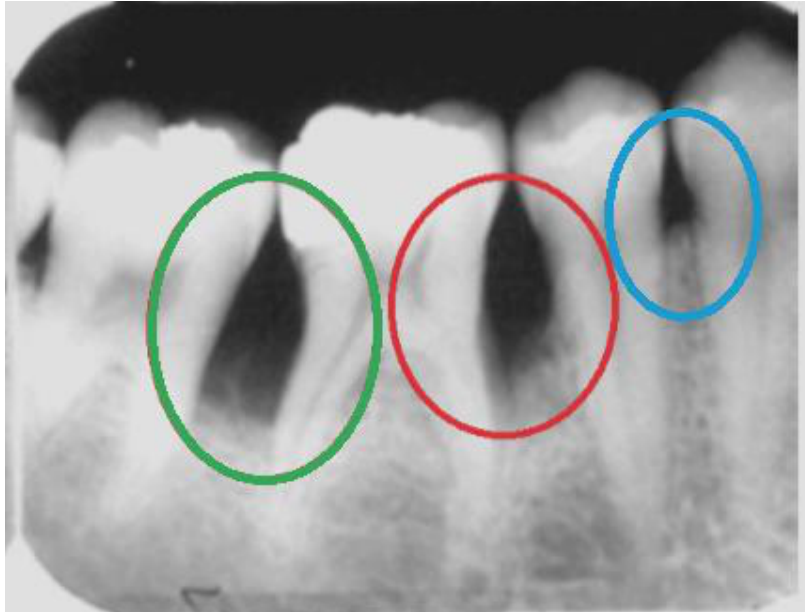
Figure 1. Examples of bone loss in a real periapical radiograph: an interproximal crater in green, vertical bone loss in red, and a horizontal bone defect in blue.